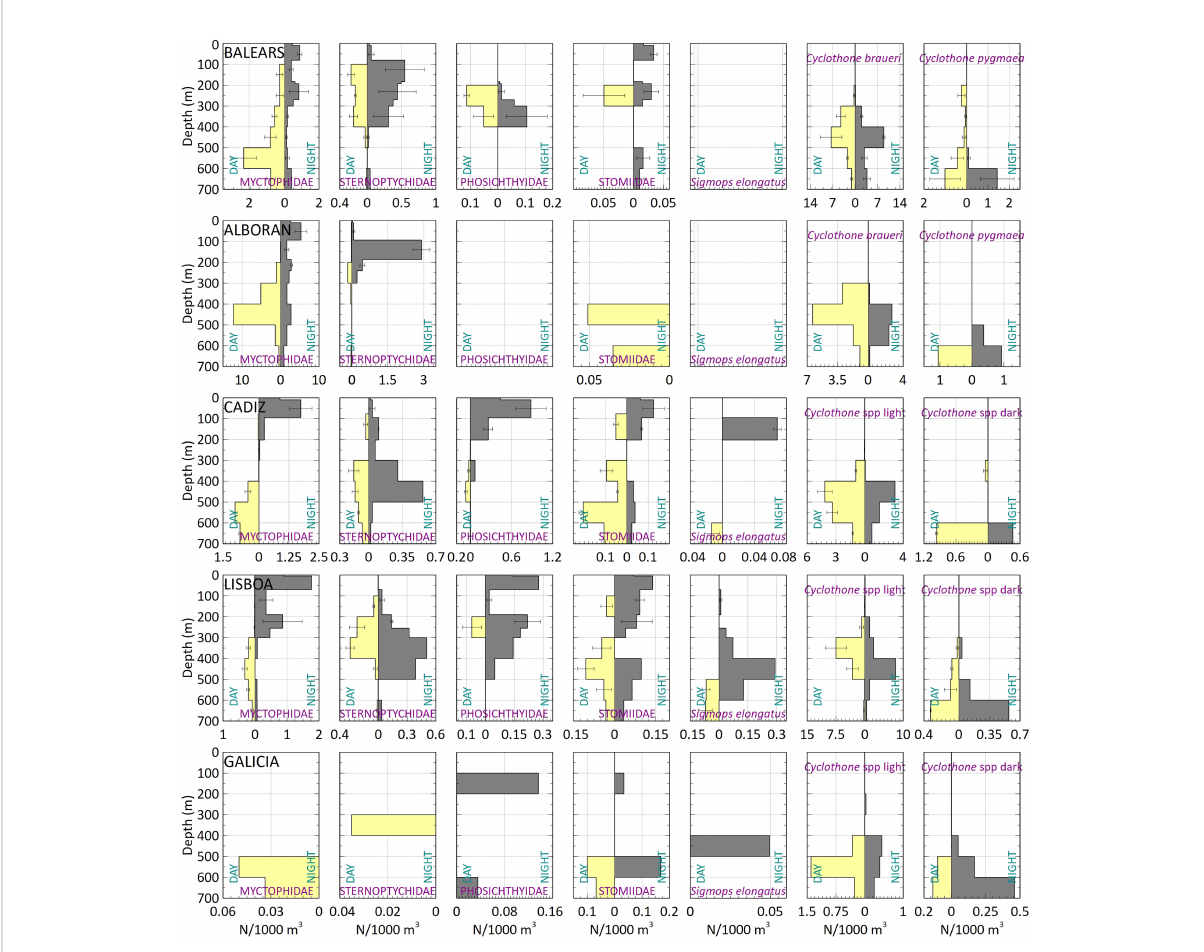
FIGURE 8 Mean vertical distribution patterns for the most abundant fi sh taxa in the different studied zones. From top to bottom: Balears, Alboran, Cadiz, Lisboa and